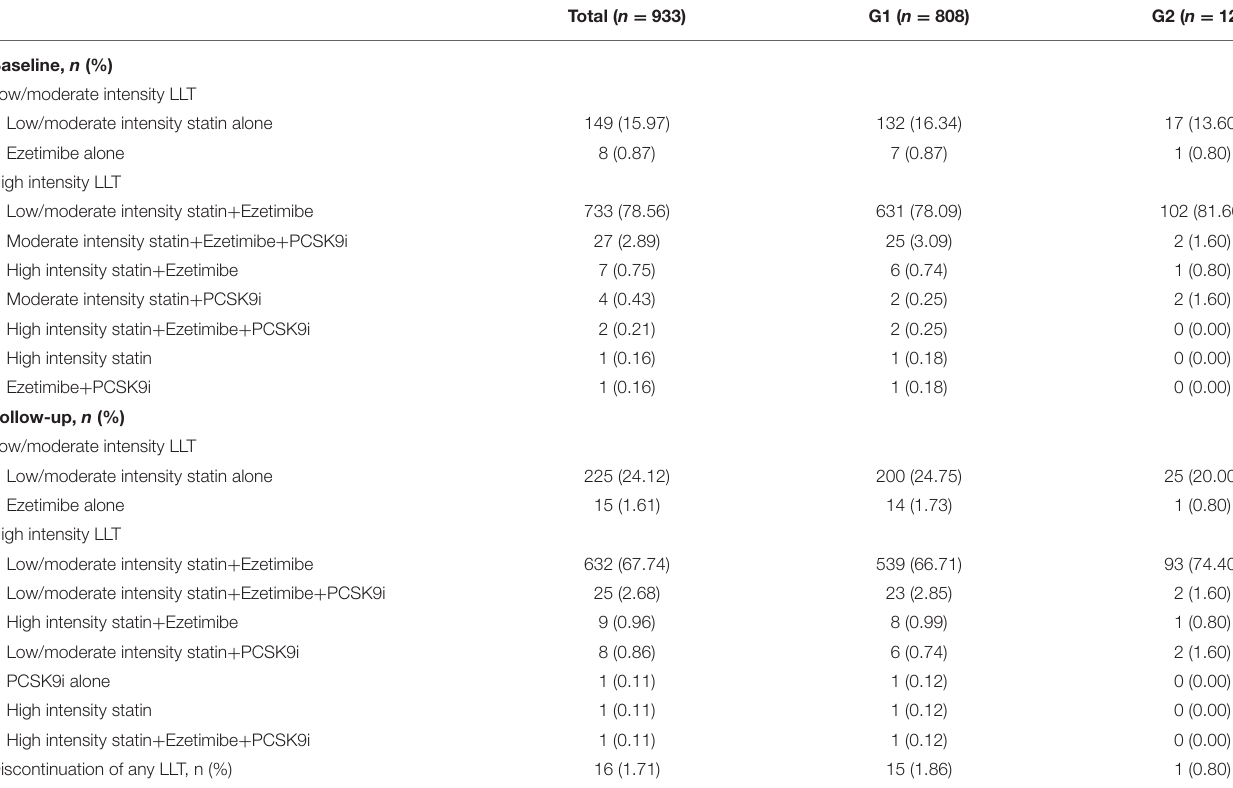
TABLE 2 | Comparison of the lipid-lowering therapy (LLT) strategies between the two groups at baseline and follow-up